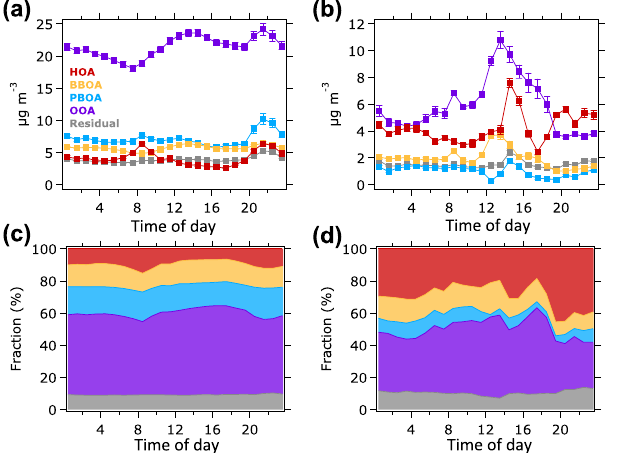
Figure 6. (a) Average concentrations of OA factors during the P1 and P2 periods. Vertical lines represent one standard deviation. The contribution of each OA factor to the total OA mass during (b) the overall, (c) P1, and (d) P2 periods are illustrated in pie charts. Resid- ual is the portion of time series OA mass spectra that could not be resolved by the ME-2